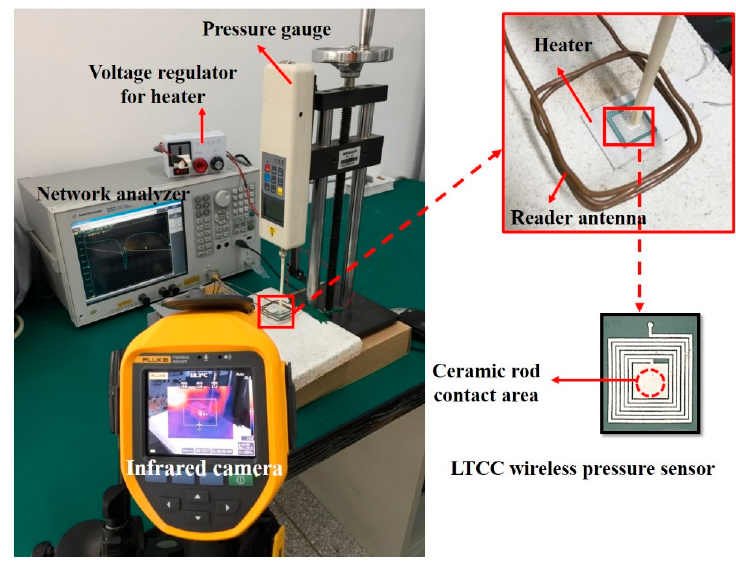
Figure 4. Photograph of the test system for temperature and pressure sensing measurement.